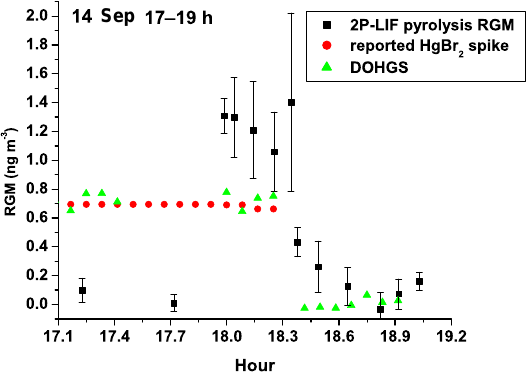
Figure 8. The 14 September measurements, hours 17–19. The means of the ambient channel (black) and pyrolyzed channel (red) are shown. The error bars show both 2 standard errors (thicker line) and 2 standard deviations.